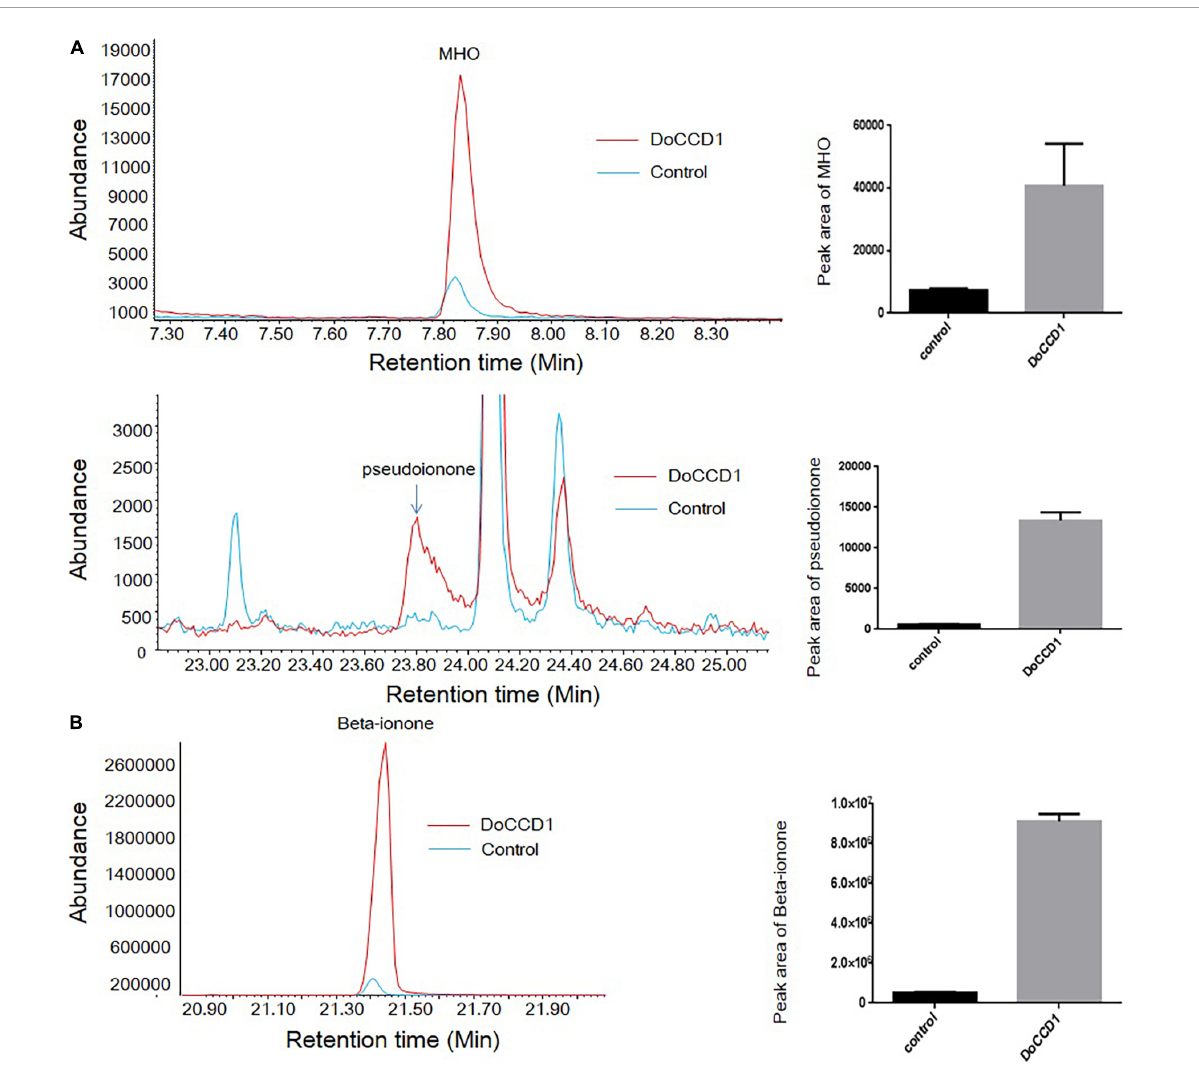
FIGURE6 Products in carotenoid-producing E. coli strains by headspace SPME-GC/MS. (A) E. coli strains can accumulate lycopene. Two peaks were identified as MHO (up) and pseudoionone (down), respectively. (B) E. coli strains can accumulate beta-carotene. The peak was identified as beta-ionone. Red lines stand for the strain containing DoCCD1 gene. Blue lines stand for the control strain without DoCCD1